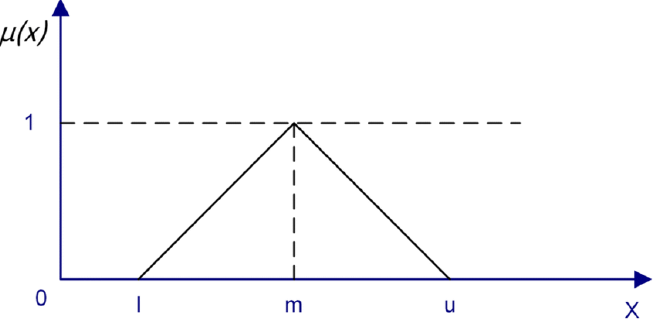
Figure 1. The membership function of the triangular fuzzy number.